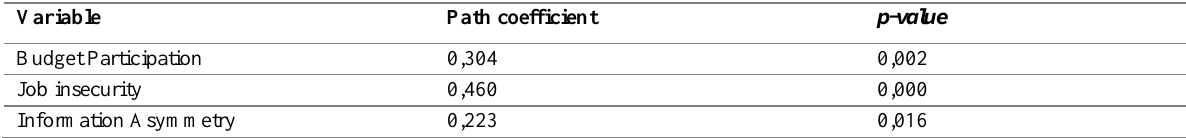
Table 6: Summary of inner model test results